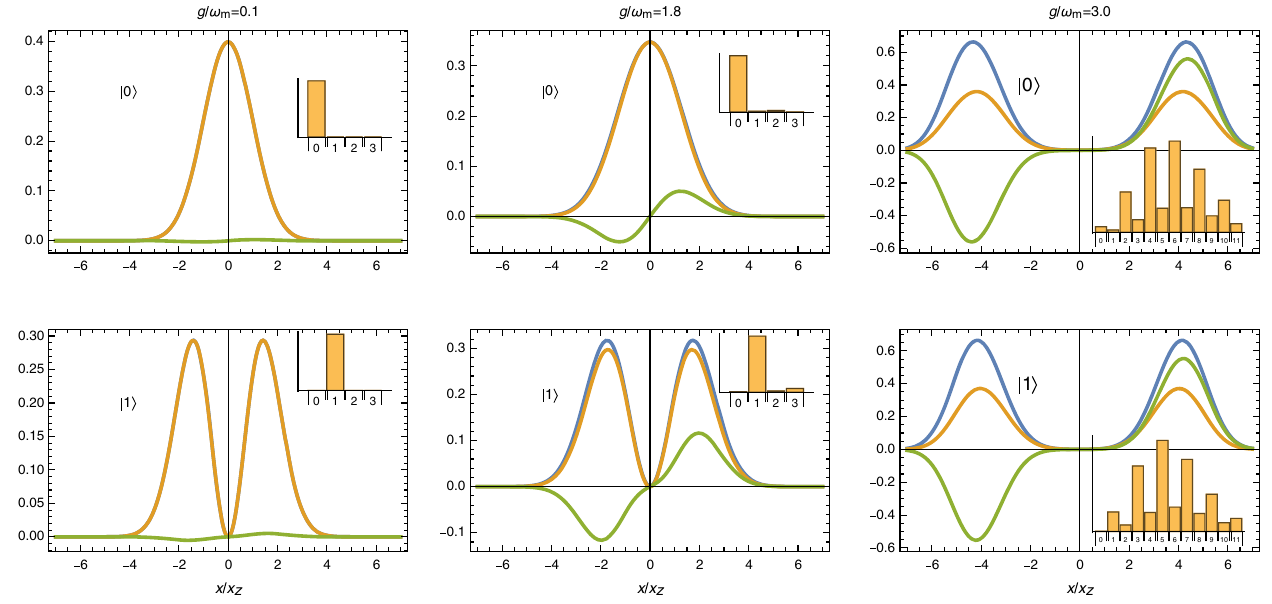
20 , g= ω 0 . 1 , 1.8, and 3.0. We m ¼ m ¼